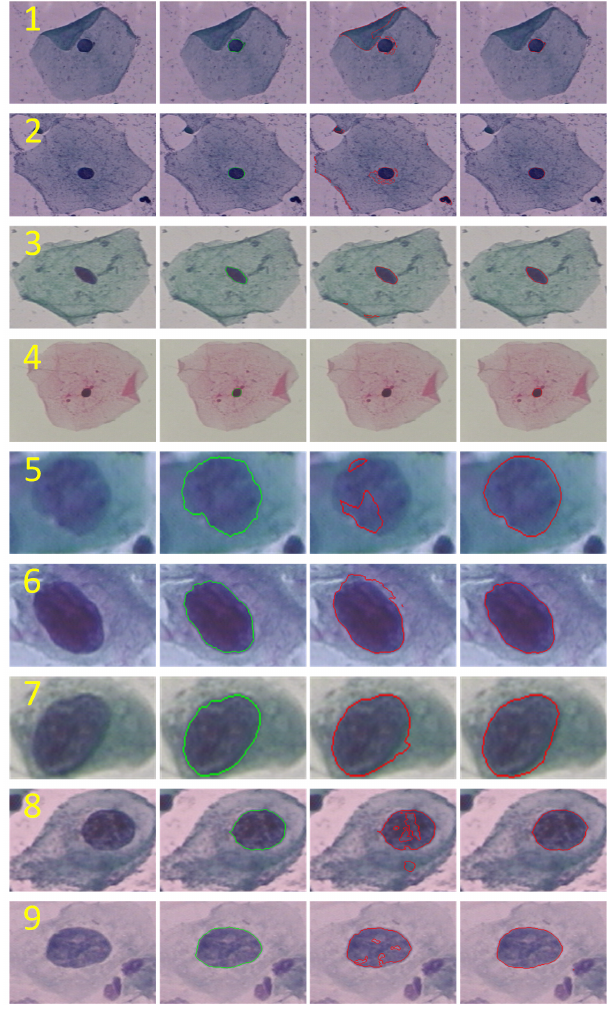
Figure 8. Visual segmentation results. From left to right: pap smear images, manual annotations, U-Net segmentation effect, and GDLAU-Net segmentation